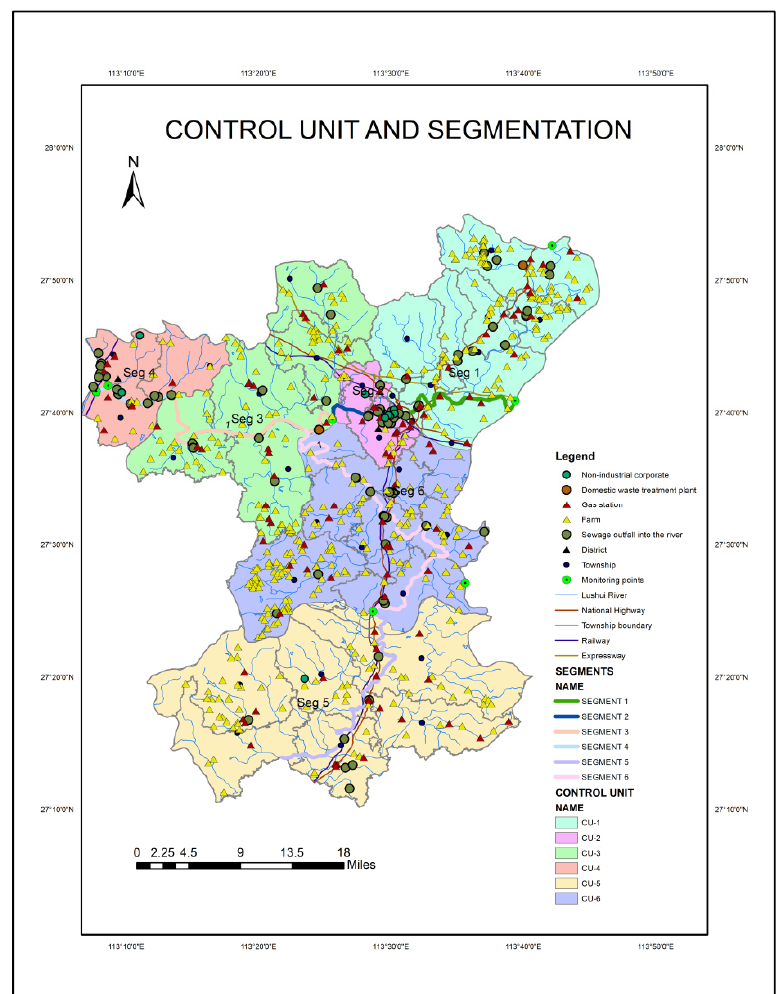
Figure 2. Division of control units and segmentation in the study area. Table 1. Segment information of Lushui River.